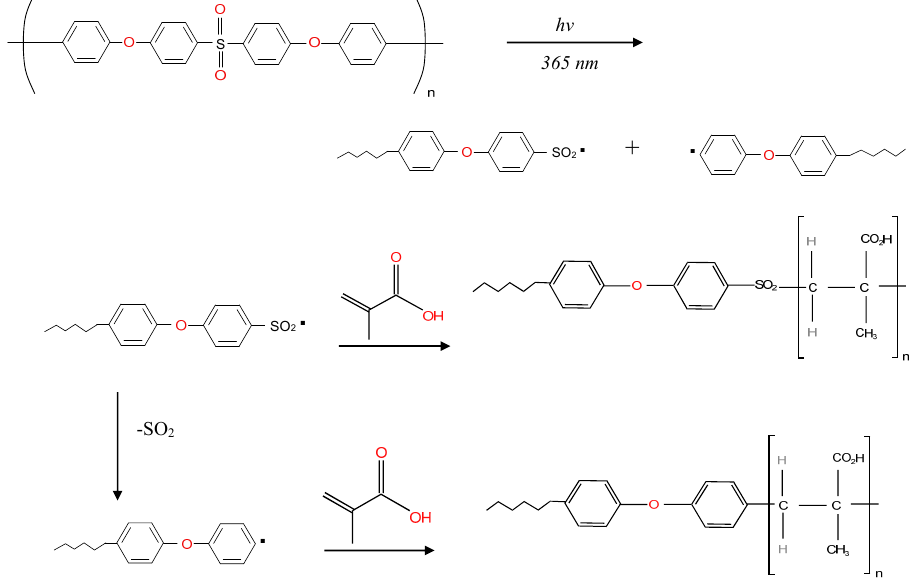
Membranes 2023 , 13 , x FOR PEER REVIEW